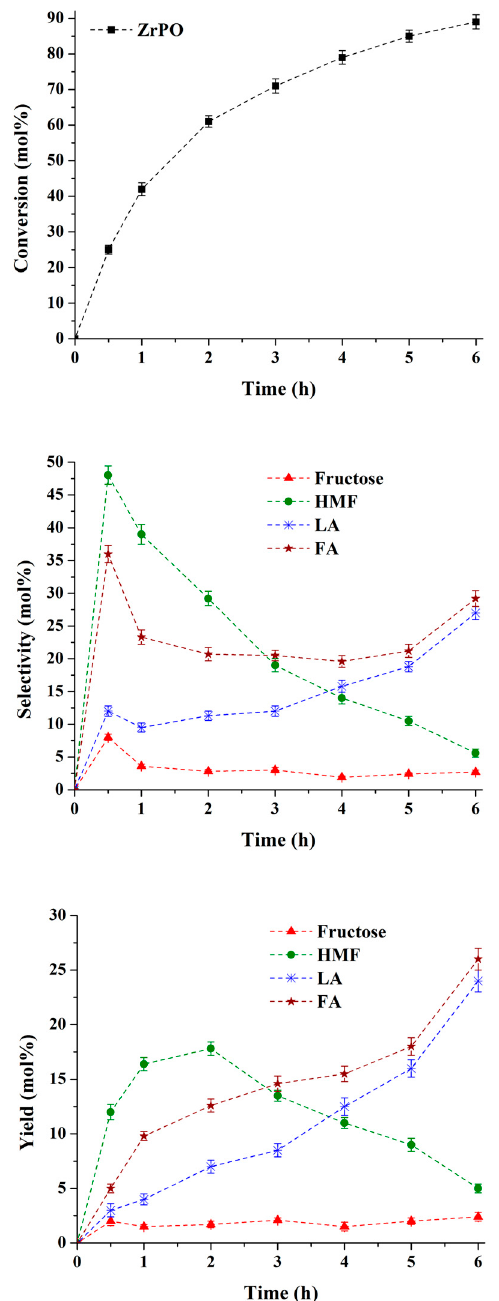
Figure 2. Glucose conversion in the presence of ZrPO as acid catalysts in autoclave at 180 ◦ C. Reaction conditions: glucose = 2.49 g; catalyst = 2.02 g; water = 47.0 g; T = 180 ◦ C. Note: where the error bars are not visible, they are smaller than the symbols.